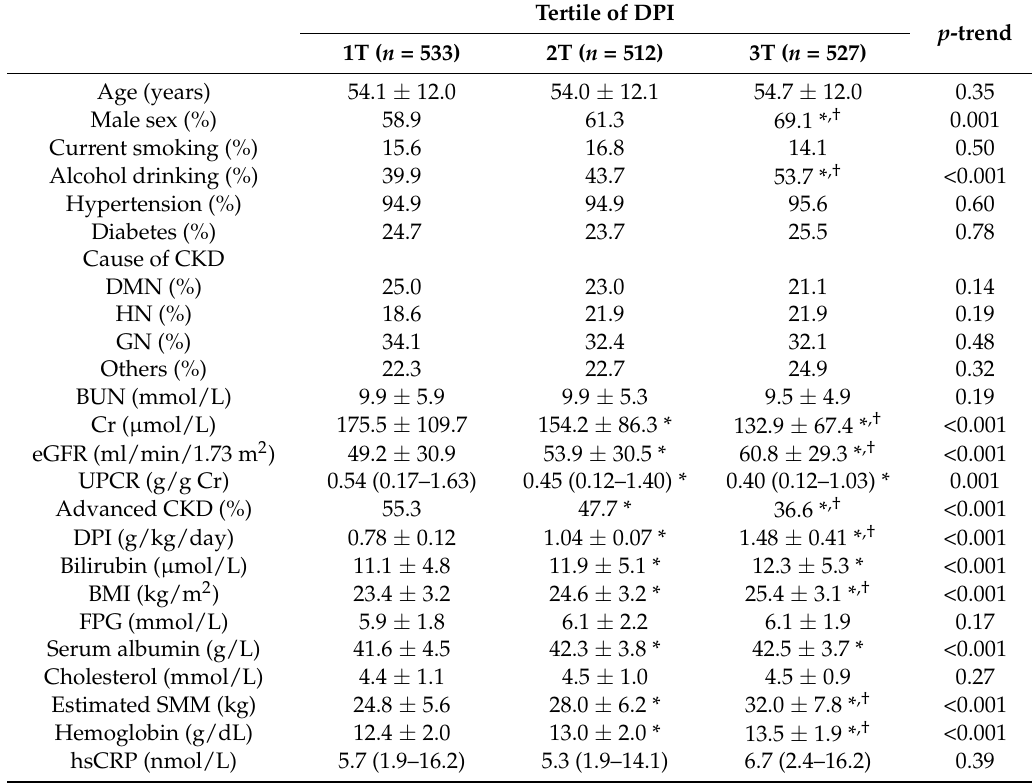
Table 1. Baseline characteristics of patients in the DPI tertile